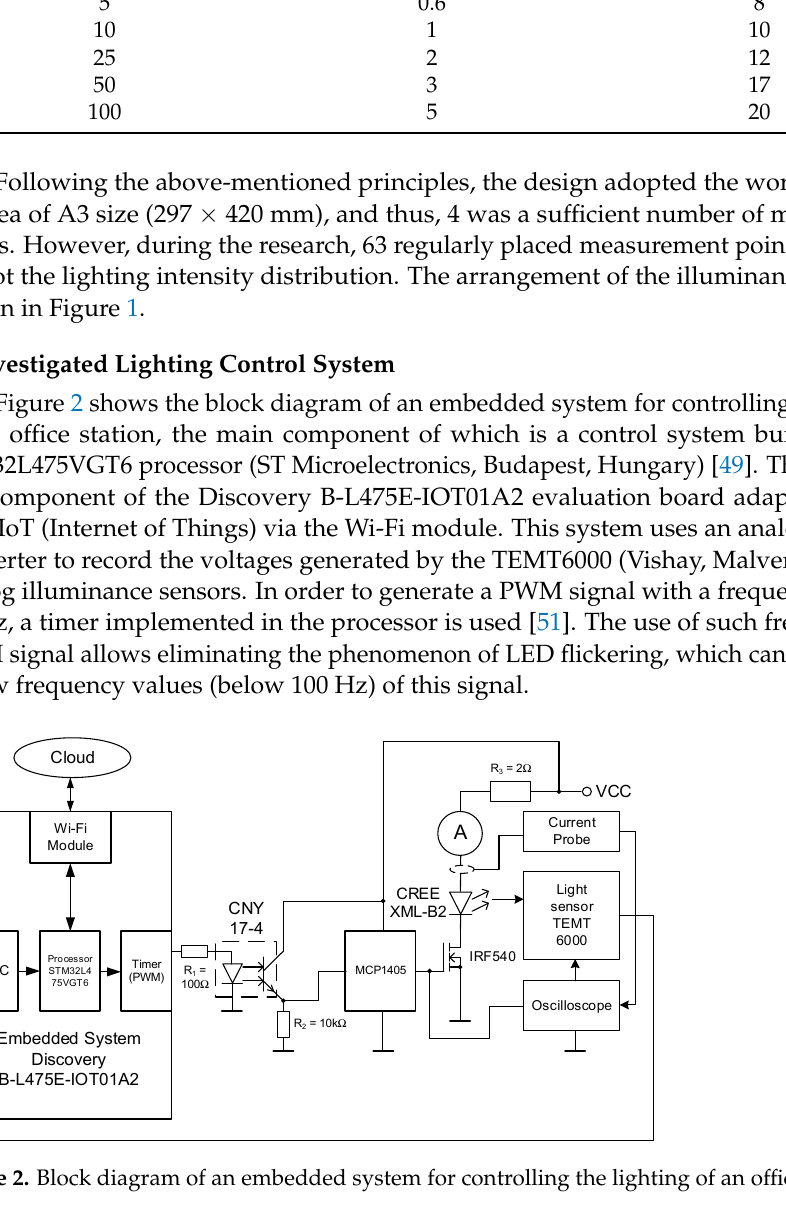
Figure 3. View of the test set ‐ up with external lighting. A plate is placed at the bottom of the test set ‐ up with 63 regularly distributed points for the placement of sensors, which allows for an easy change in the position of the sen ‐ sors. The position of the sensors could be changed within the accepted working area of the dimensions of 297 × 420 mm, in 7 rows and 9 columns. The measuring surface pre ‐ pared in such a way ensures that the sensors are precisely positioned each time, which allows obtaining reliable results and measurement of illumination intensity distribution. As mentioned earlier, 4 positions are selected in which sensors E 1 , E 2 , E 3 and E 4 are placed, as shown in Figure 1. During the investigations, the height at which the point light source controlled by the system is fixed is 50 cm.